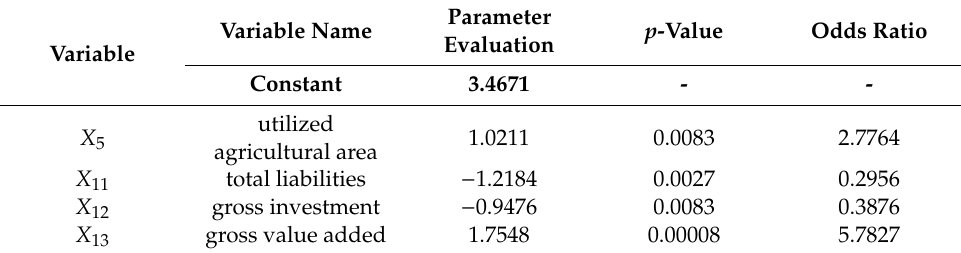
Table 6. Evaluation of logit model parameters.